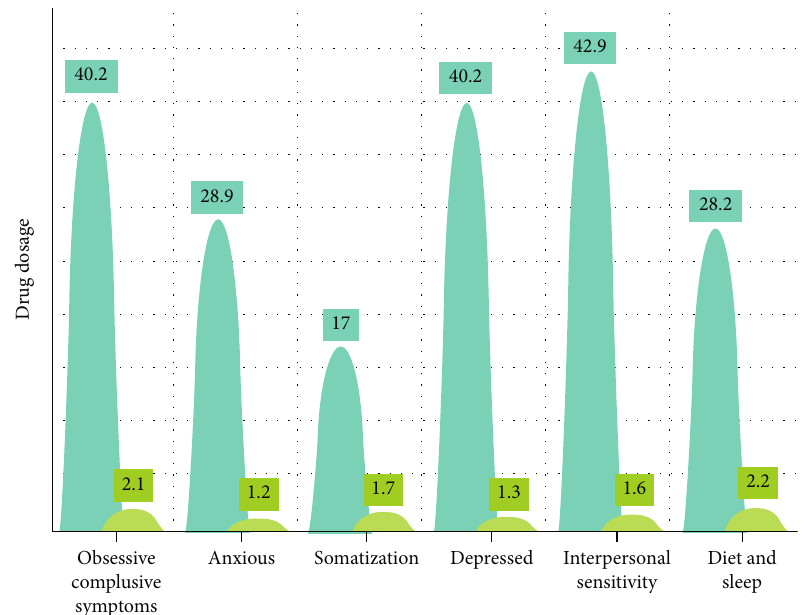
Figure 4: Analysis of variance of mental health